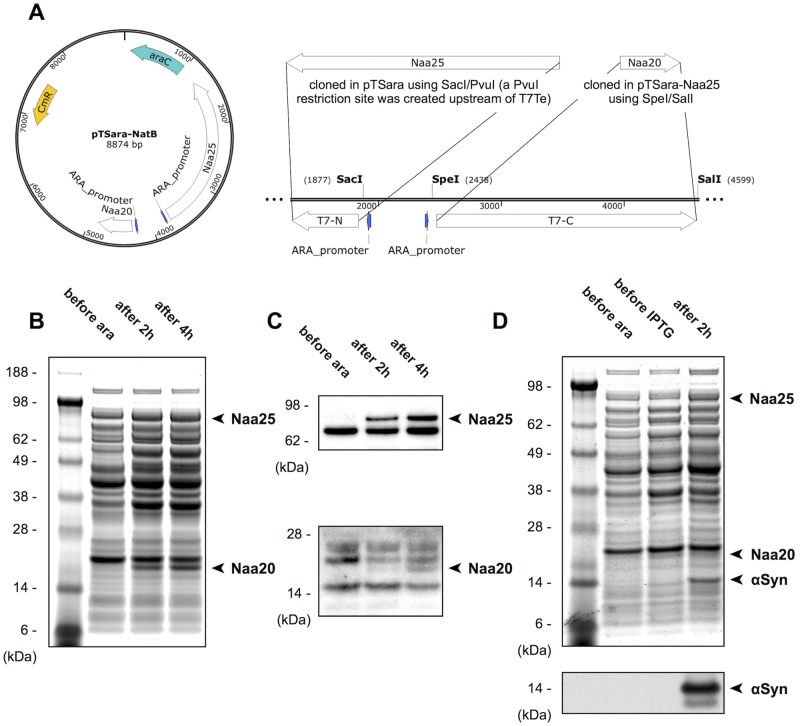
Molecular cloning and characterization of pTSara-NatB.(A) Plasmid map and cloning strategy of pTSara-NatB. (B) CBB-stained SDS-PAGE of pTSara-NatB-transformed E. coli (PBS-soluble) lysates before and after (2, 4 hrs.) induction with 0.2% L-arabinose. Bands corresponding to the regulatory (Naa25) and catalytic (Naa20) subunits of the NatB complex are marked. (C) Western blots of pTSara-NatB-transformed E. coli lysates before and after (2, 4 hrs.) induction with 0.2% L-arabinose. Antibodies to the human homologs of the yeast NatB components were used for detection (top Naa25, Anti-C12orf30 1:1000; bottom Naa20, Anti-NAT5 1:1000). Non-marked bands are cross-reactive E. coli proteins. (D, top) CBB-stained SDS-PAGE of pET-alpha-synuclein+pTSara-NatB co-transformed E. coli lysates before 0.2% L-arabinose induction (before ara) or 1 mM IPTG induction (before IPTG, added 30 min after L-arabinose) and 2 hrs. after IPTG induction. Both subunits of the NatB complex and αSyn are marked. (D, bottom) αSyn Western blot of co-transformed E. coli lysates, in order to confirm the absence of any cross-reactivity between L-arabinose and IPTG induction, 2F12 (1:10,000) was used for αSyn detection.